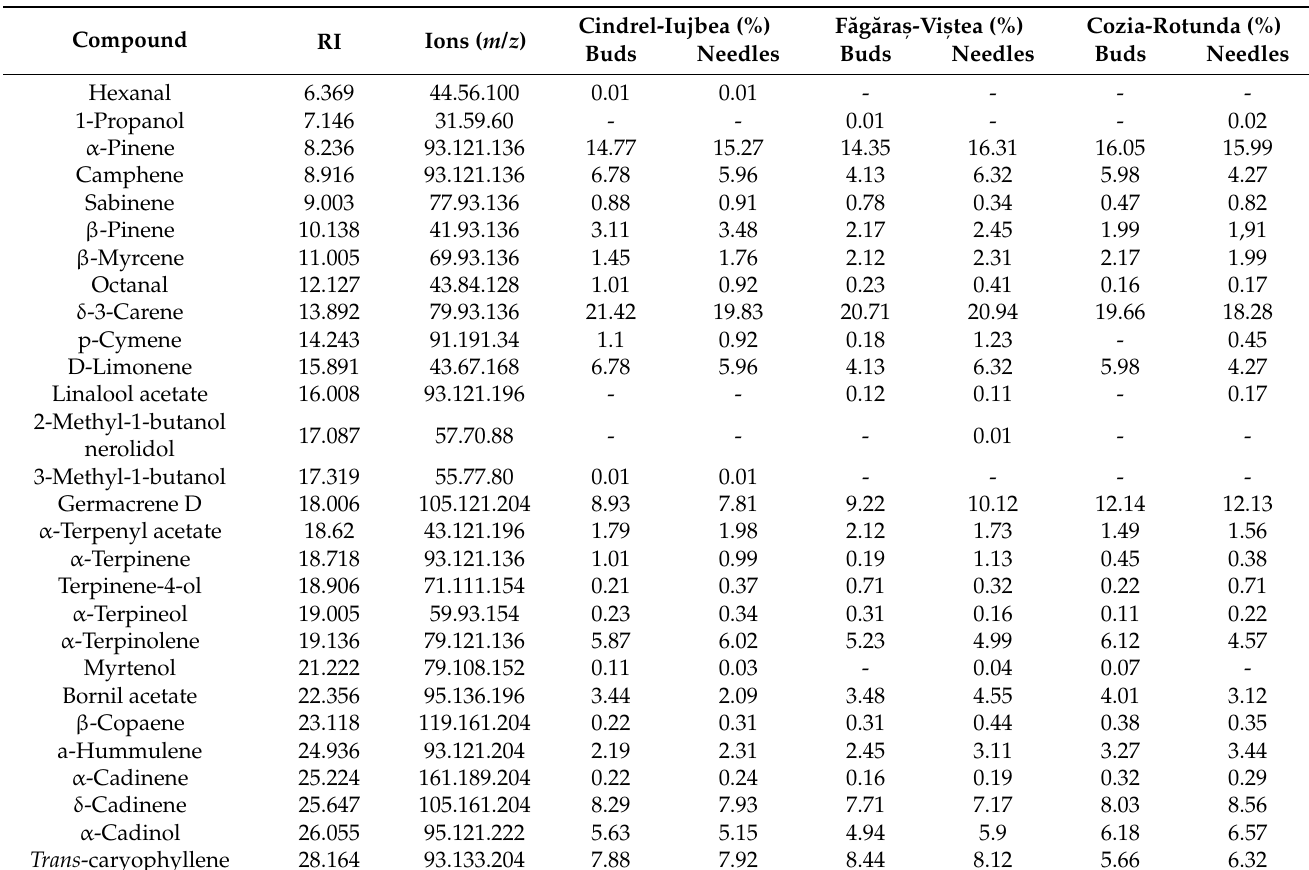
Table 2. Chemical composition of Pinus mugo bud and needle extracts from three mountainous areas in Romania (Cindrel-Iujbea, F ă g ă ras -Vi¸stea, ,